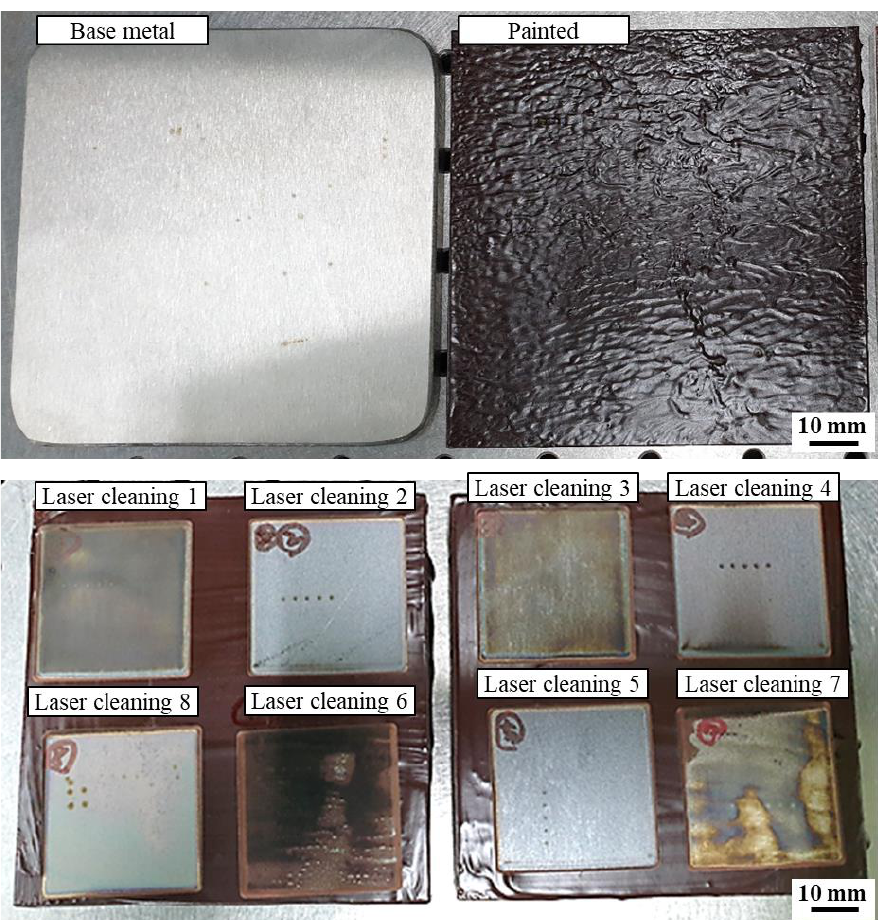
Figure 2. Images of the base metal, painted, and laser paint-cleaned specimens.